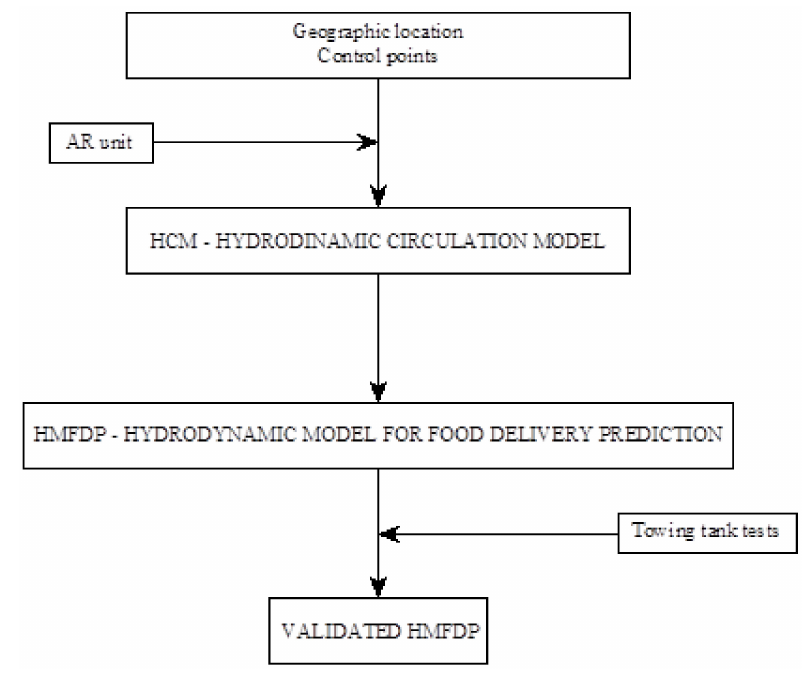
Figure 3. Flowchart with the methodology employed.